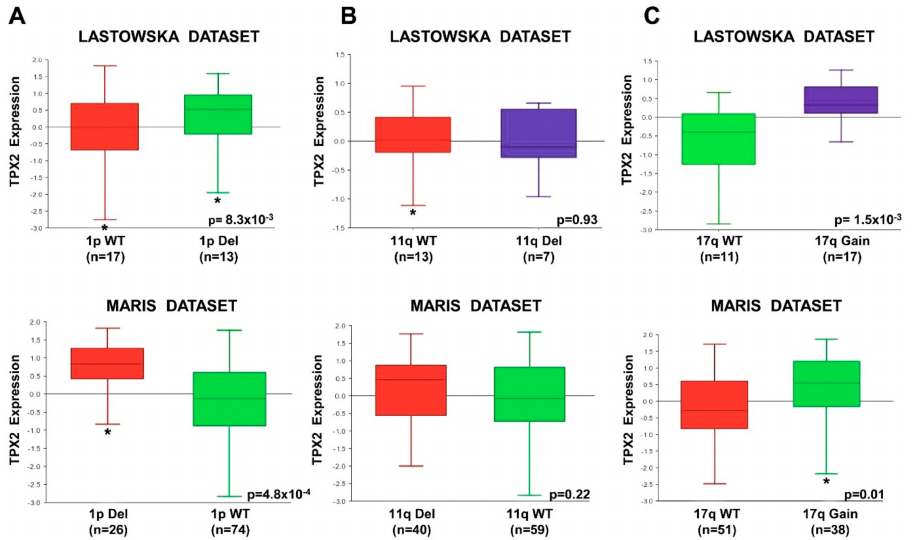
Figure 9. TPX2 Expression Compared to Chromosome 1p, 11q, and 17q status. Using the R2 Genomics Analysis and Visualization Platform, TPX2 gene expression in the Lastowska (upper) and Maris (lower) data sets was compared in patients with wild-type chromosome 1p or with 1p deletion ( A ), in patients with wild-type chromosome 11q or with 11q deletion ( B ), and in patients with wild-type chromosome 17q or with 17q gain ( C ). Patients’ numbers are shown in parentheses. (WT = Wild Type; Del = Deletion) (* p <